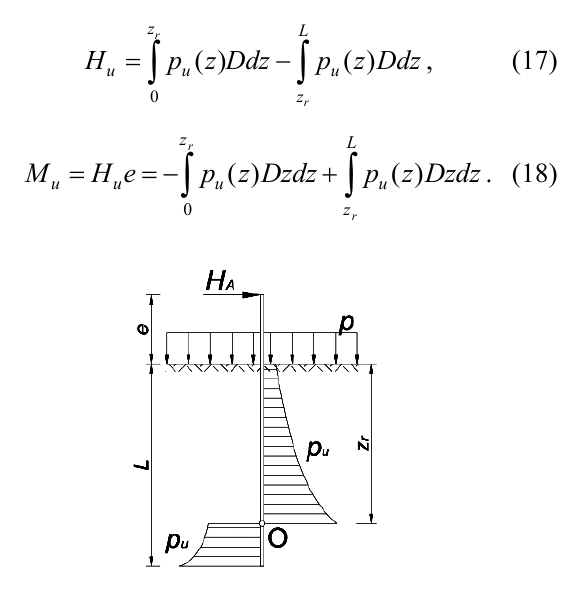
Fig. 4. A scheme of rigid pile embedded in soil and subjected to lateral